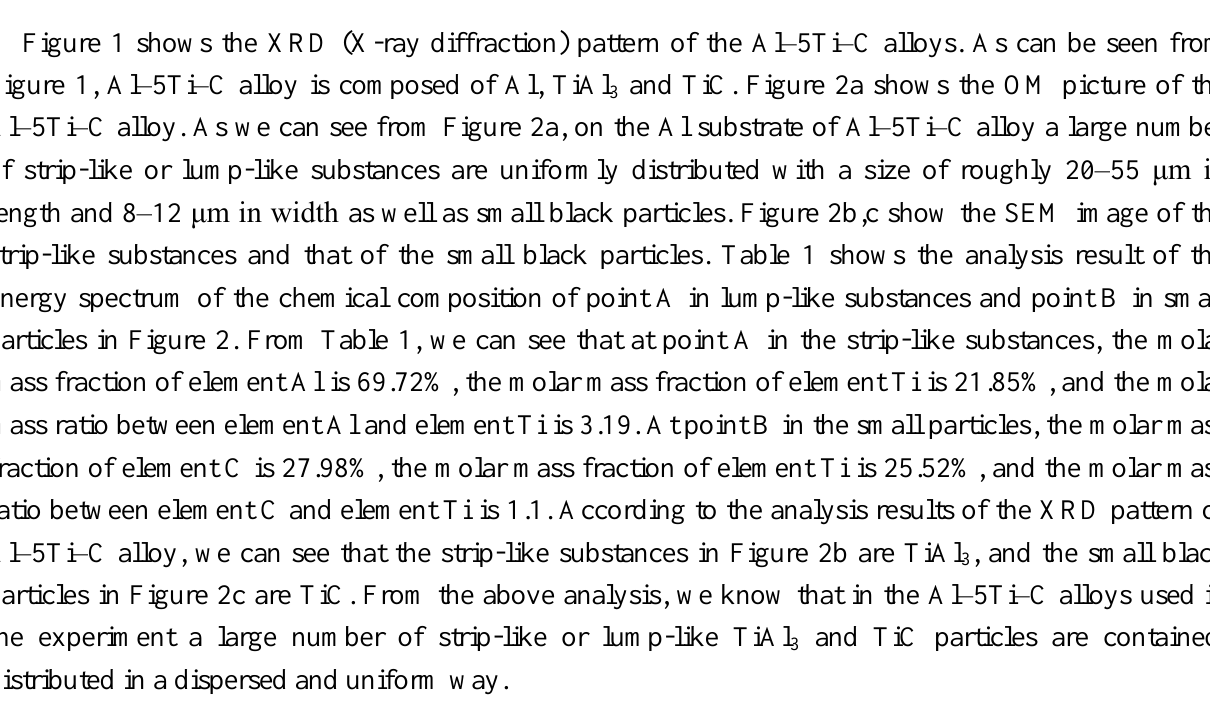
Figure 1. XRD pattern of Al–5Ti–C master alloy.